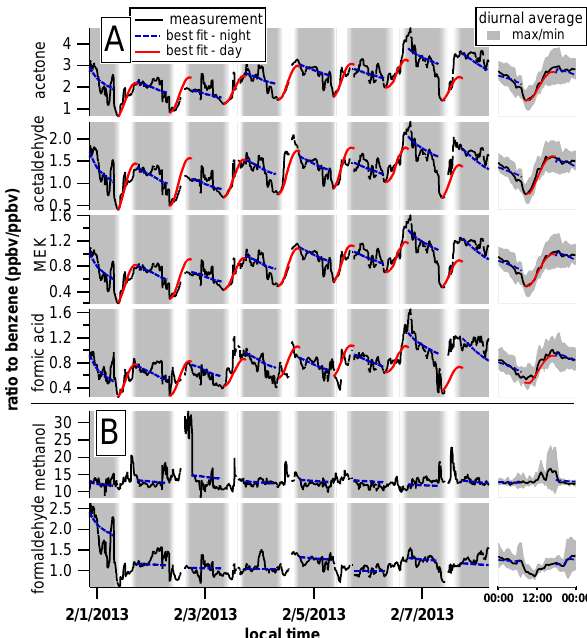
Figure 9. Analysis results for oxygenated compounds. Measured ratio is in black, nighttime best fit in blue, and daytime best fit in red. (a) The best fit is able to reproduce VOC trends during the day for acetone, MEK, acetaldehyde, and formic acid. (b) The best fit does not reproduce nighttime variability or trends in methanol and formaldehyde, which may have substantial primary sources uncor- related with